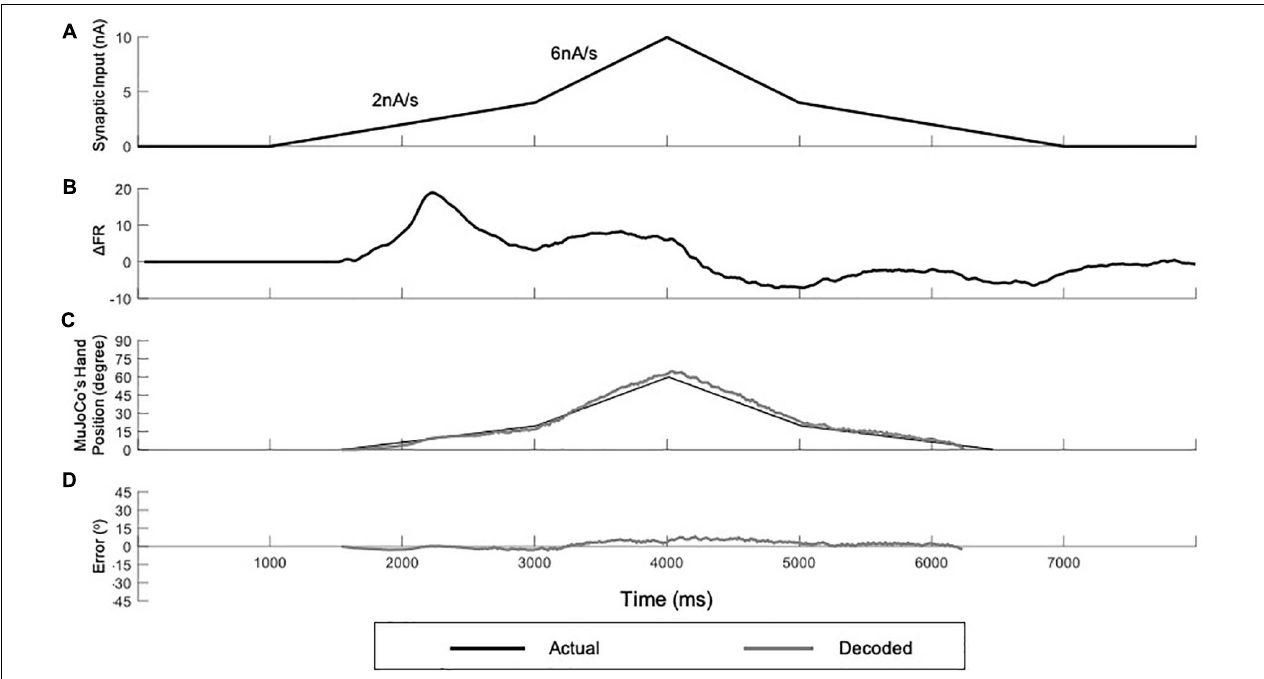
FIGURE 7 | Testing of the adaptive 3-speed decoder using a variable input of changing activation speed. (A) Profile of the synaptic input to the pool model. The input increases at 2 nA/s for 2,000 ms, then increases by 6 nA/s for 1,000 ms to reach a peak activation of 10 nA. The input decreases at the same rates to return to zero. (B) The rate of change in pool firing rate. This measure is used to control the auto-switching among speed settings in the adaptive decoder. (C) Comparison of MuJoCo’s hand position when driven by the actual (black) vs. decoded (gray) inputs. (D) Instantaneous error in MuJoCo’s hand position when driven by the adaptive 3-speed decoder.